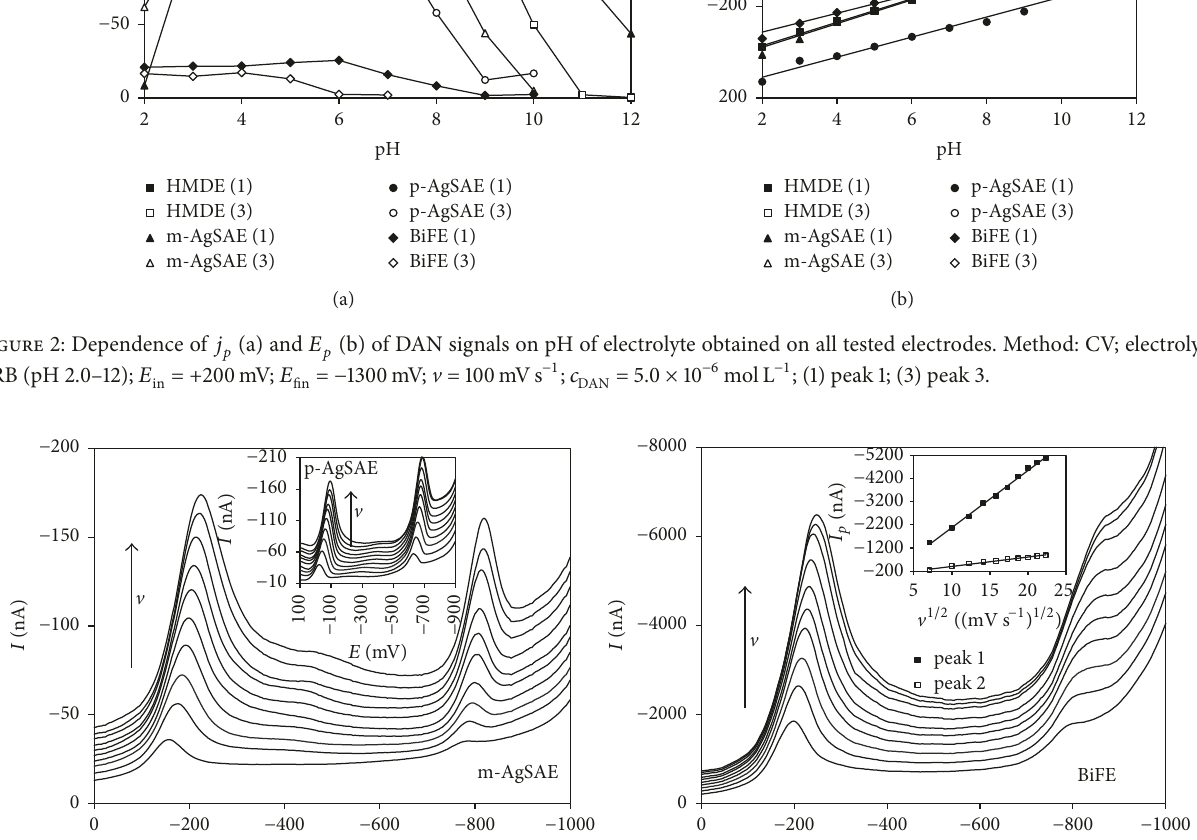
Figure 3: DC voltammograms of 5.0 × 10 −6 mol L −1 DAN recorded on m-AgSAE, p-AgSAE, and BiFE in dependence on scan rate. Electrolyte: BRB (pH 6.0 (AgSAEs) and 5.0 (BiFE)); 𝐸 in = +200 mV, 𝐸 fin = − 1200 mV; V = 50–500 mVs −1